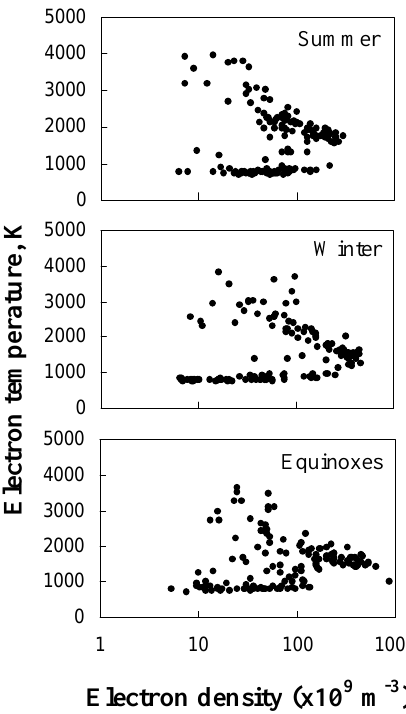
Fig. 9. Variation of observed electron temperature (all data) with the observed electron density in the corresponding